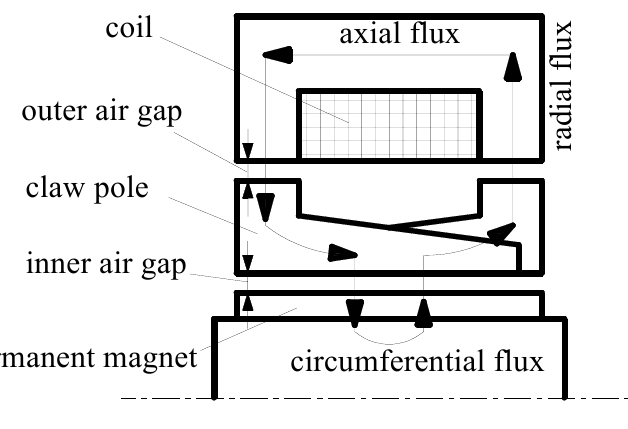
Figure 5. Flux path in one pole of the BDRM. coil